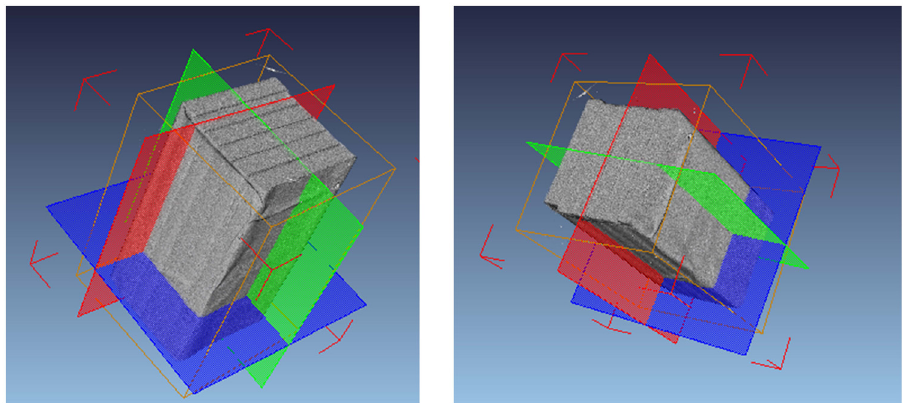
Figure 2: Illustration of slice selection from X - ray μ CT experiment, where the red slice parallels to the fi ber direction and vertical to the thickness direction of composite, noted as the fi rst direction; the green slice parallels to the fi ber direction and thickness direction of composite, noted as the second direction; the blue slice vertical to the fi ber direction and parallels to the thickness direction of composite, noted as the third direction.